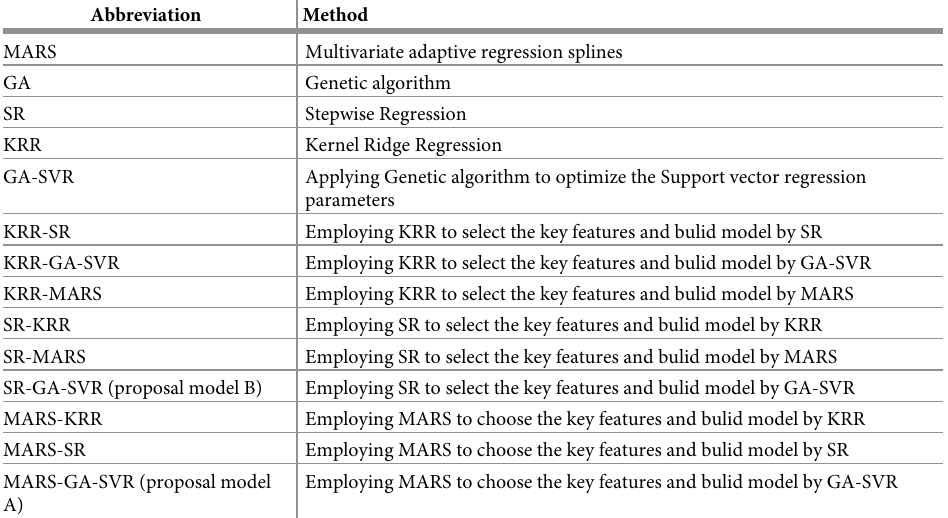
Table 3. The meaning of model